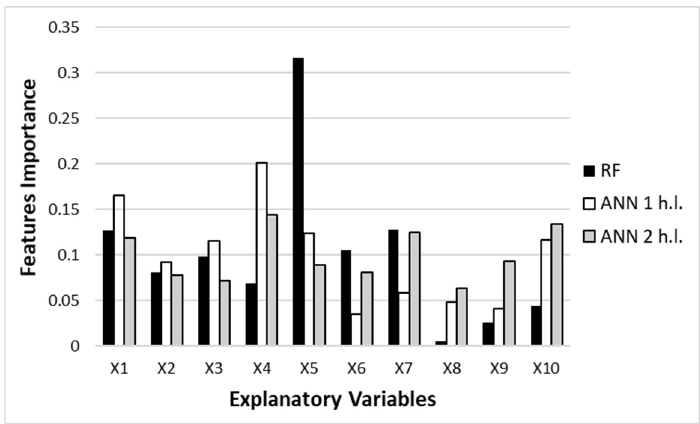
Figure 5. Comparison between features’ importance of RF and ANN (with one or two hidden layers) in the aggregated approach.